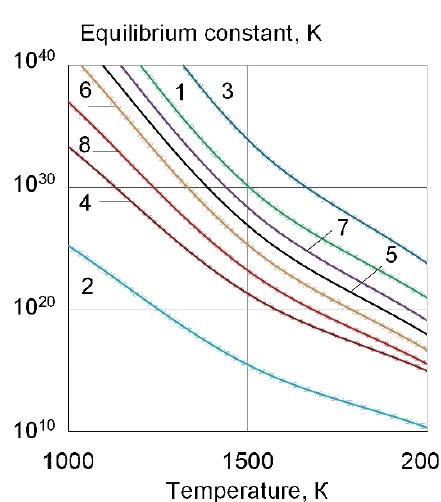
Figure 3. The equilibrium constants of the (1–4) deoxidation and (5–8) desulfurization reactions in the interaction of the REEs of FeO and FeS.